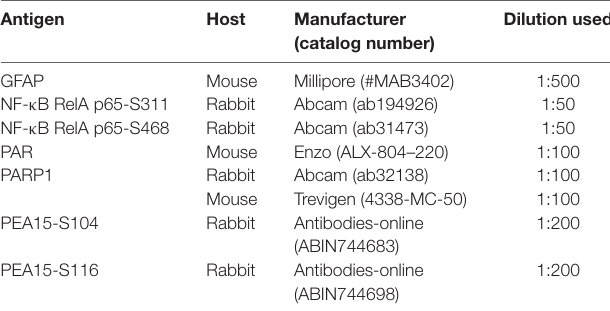
TABLE 1 | Primary antibodies used in the present